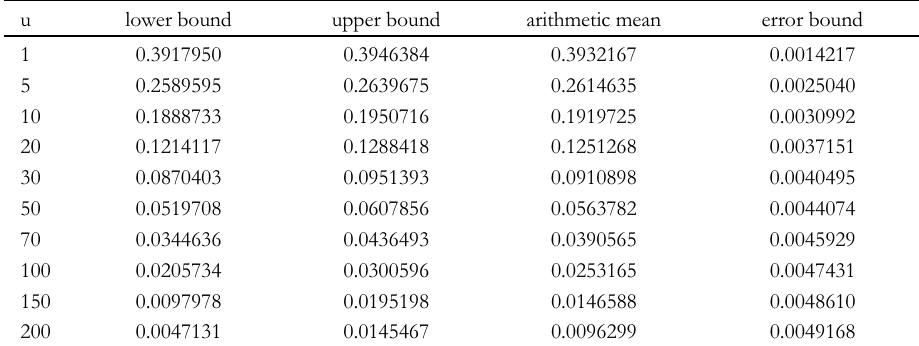
Lognormal, with mean 1 , variance 25.53372 and (cid:84) = 1 , using (cid:39) (cid:32) 0.01